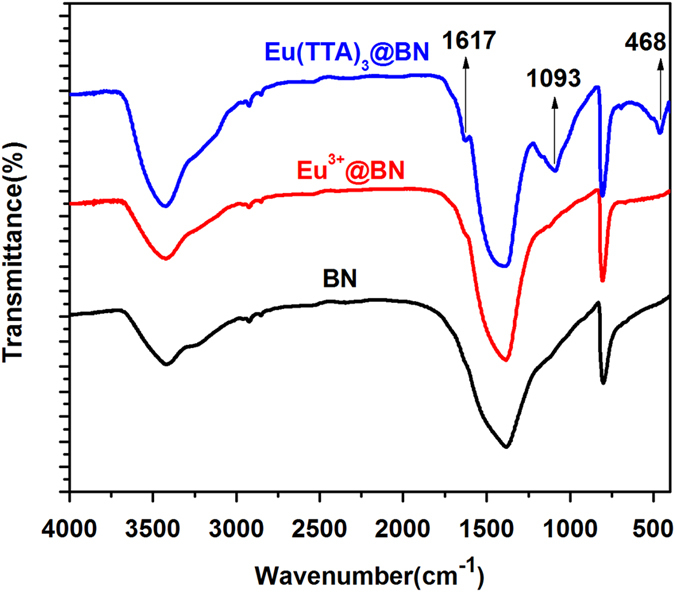
FTIR spectra of porous BN (a), Eu3+@BN (b) and Eu(TTA)3@BN (c) samples.